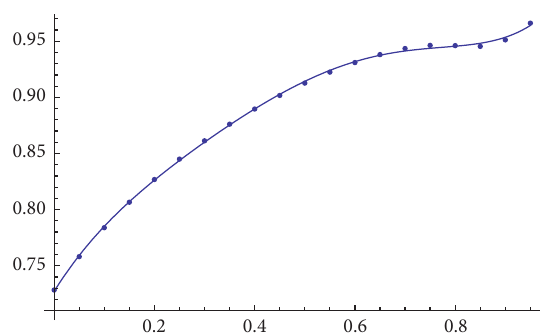
Figure 3: Optimal value of 𝛼 for each value of 𝑒 ∈ [0,0.95]